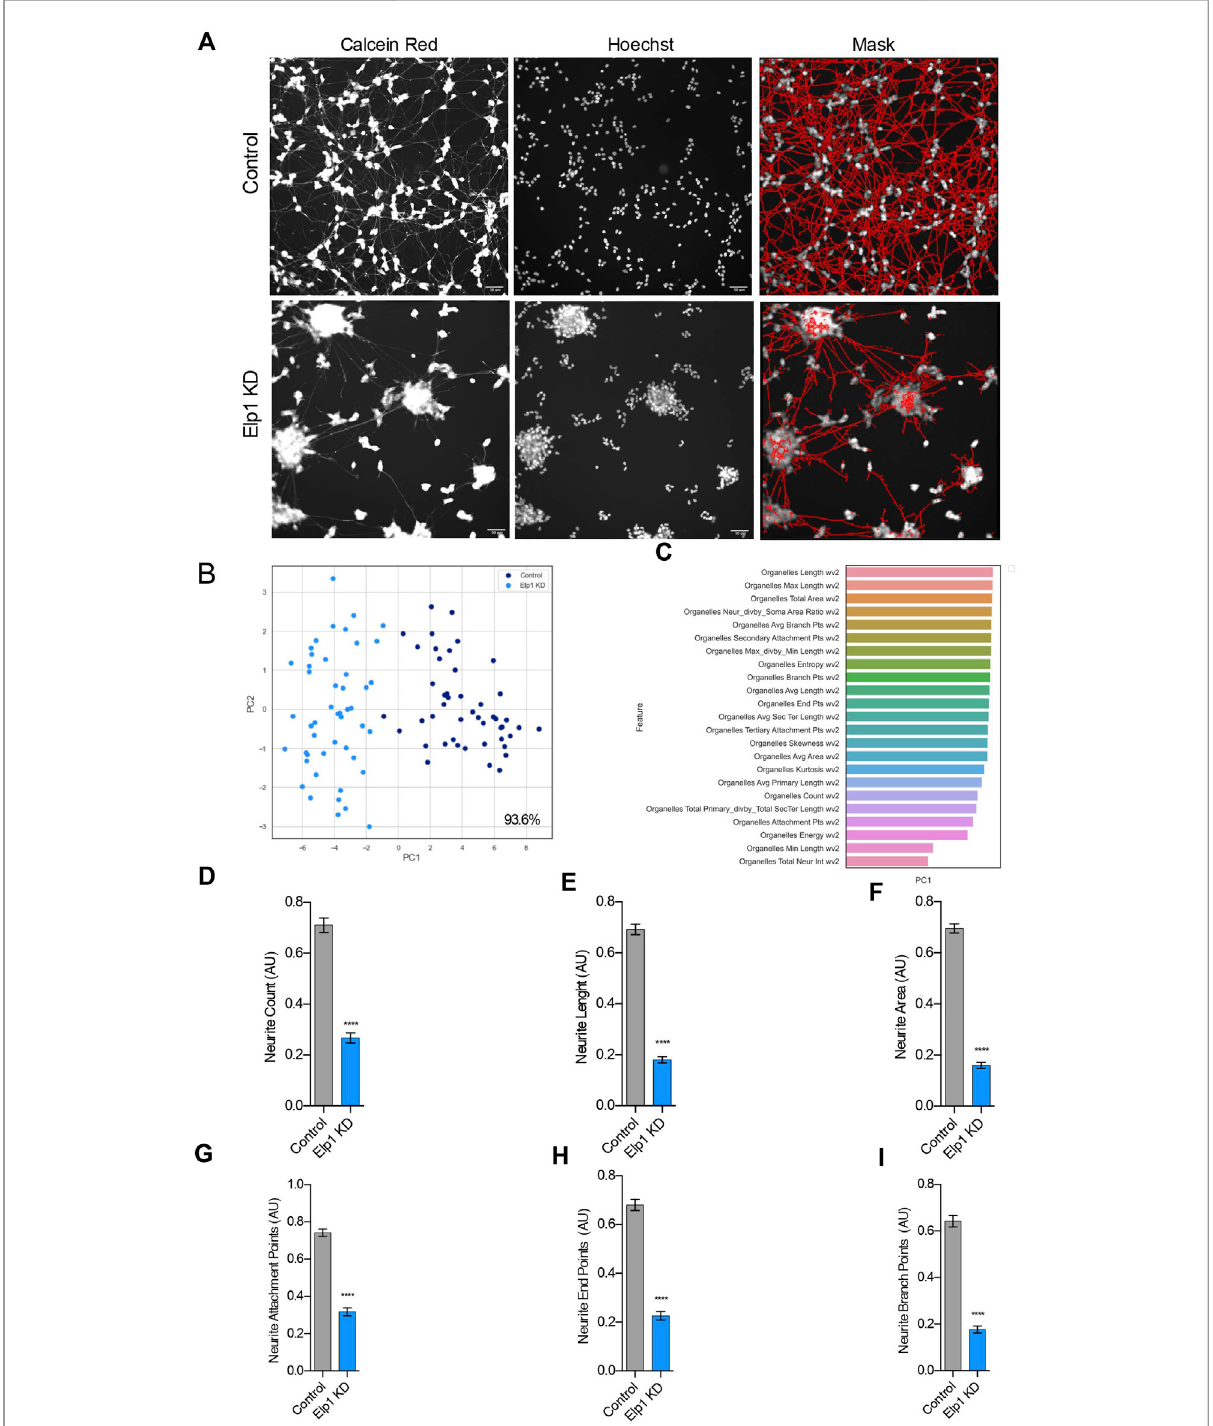
FIGURE 1 Elp1 is involved in neurite morphology, Depletion of Elp1 Causes Defective neurite outgrowth in differentiated SHSY5Y cells. (A) Representative images of Live fl uorescence microscopy staining of differentiated SHSY5Y cells control versus Elp1 KD using Calcein AM (Red) and Hoechst (Blue) to visualize neurite morphology. on the right side; segmentation of neurites by InCarta software. Scale bar is 50 µm. (B) Two dimension principal component analysis (PCA) plot of stained cells based on morphological features. Symbols in dark blue represent the control cells; symbols in lightbluerepresent Elp1KD cells.eachcirclerepresentdataextracted from20 fi eldscomingfromonewell, each fi eldcontainhundreds ofcells. PCA Score93.6% (C) PlotoffeaturescontributiontotheseparationinthePCAanalysis (D – I) Quanti fi